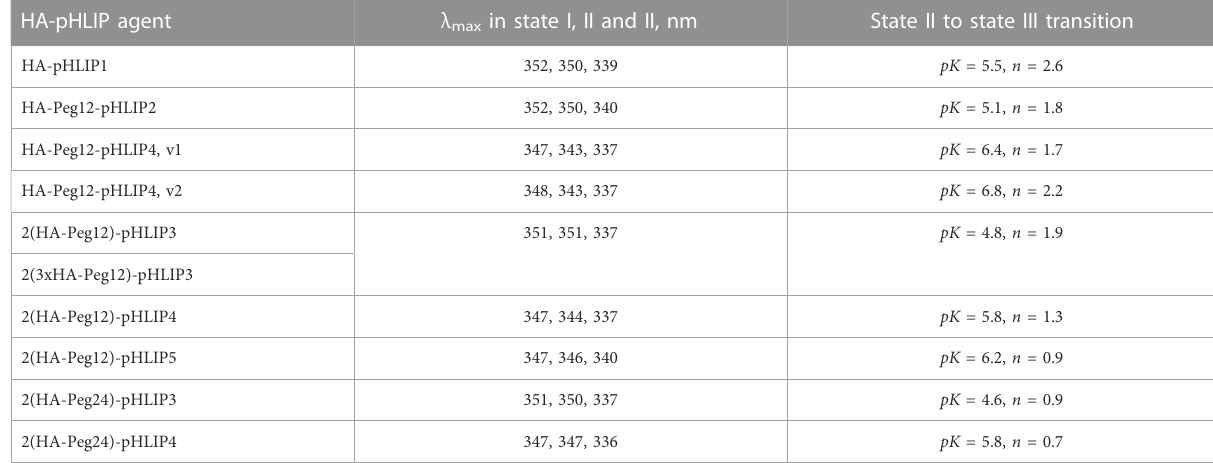
TABLE2FluorescenceparametersofHA-pHLIPsinstateI(HA-pHLIPinsolutionatpH8),stateII(HA-pHLIPwithPOPCliposomesinsolutionatpH8)andstateIII (Ha-pHLIP with POPC liposomes in solution at pH3), and the mid-points ( pK ) and cooperativities ( n ) of state II to state III transitions are shown. HA-pHLIP